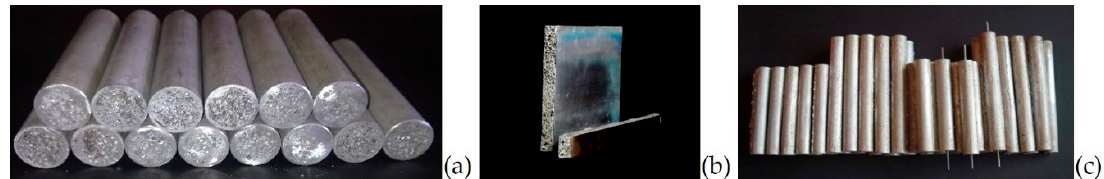
Figure 12. In-situ foam filled tubes (150 mm in length, 30 mm in outer diameter) ( a ), in-situ sandwich foam panels (rectangular panel: 210 × 250 × 15 mm 3 -foam core and two aluminum sheets 1.5 mm in thickness; long panel: 300 × 35 × 15 mm 3 -foam core; two aluminum sheets 1.5 mm in thickness) ( b ), and simple and in-situ reinforced foams (length: 150 and 200 mm; diameter: 25 mm) made of aluminum alloys ( c ).